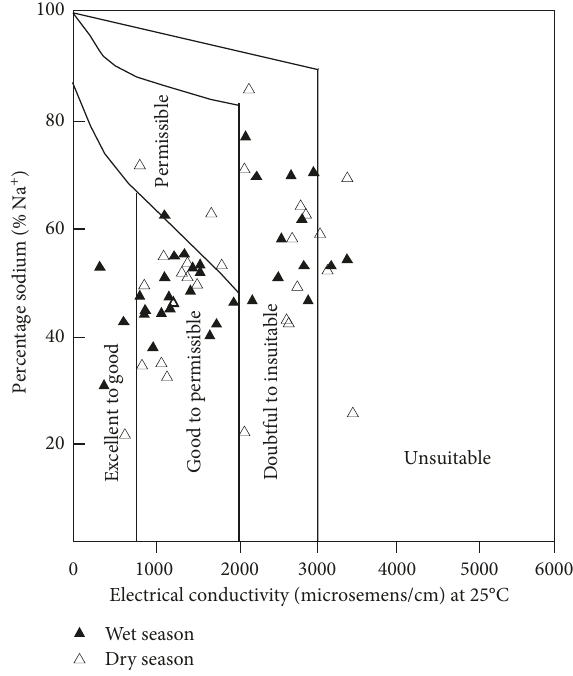
Figure 18: Wilcox diagram for the study area.